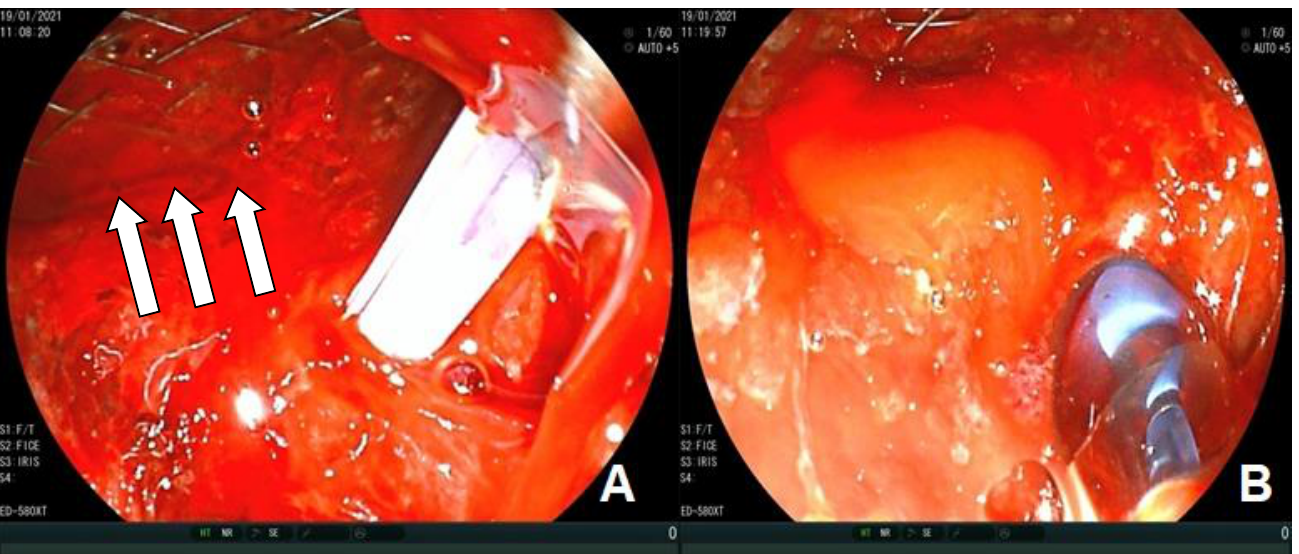
Figure 3. ( A , B ) ERCP (Endoscopic Retrograde Cholangio-Pancreatography)examination. Neoplastic infiltration (arrows) through duodenal mesh with consequent detection of stent obstruction.